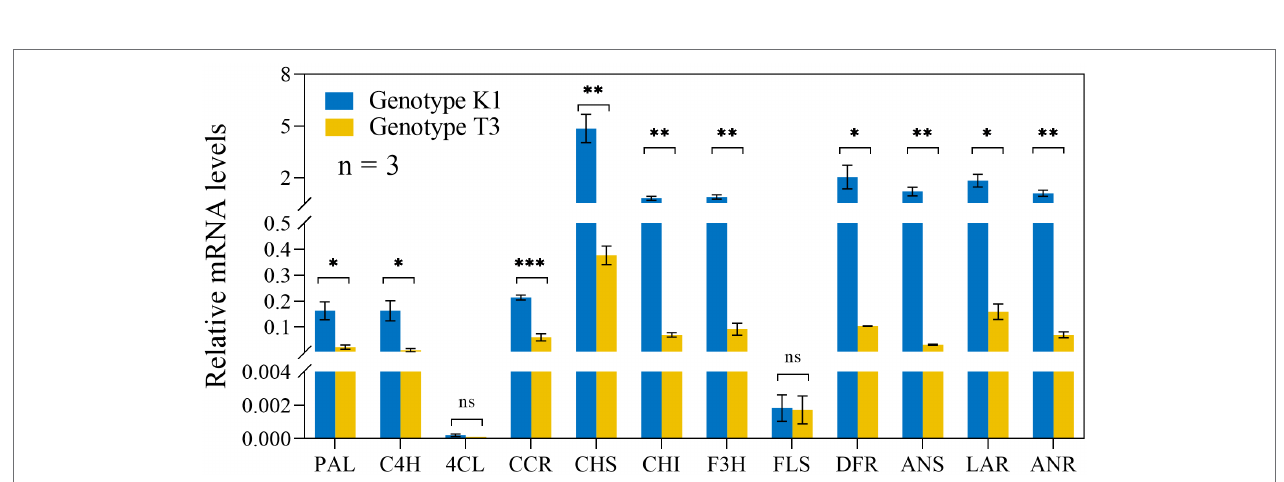
FIGURE 9 | Relative expression levels of genes involved in the phenylpropanoid pathway in leaves of Kreuzkogel 1 (K1) and Tenno 3 (T3) without B. cinerea inoculation were measured via qRT-PCR. All values were normalized to the expression level of the H4 and UBC9 housekeeping genes. Significant differences between two genotypes, based on the Wilcox test, are represented by ns p > 0.05, * p < 0.05, ** p < 0.01 and *** p < 0.001. PAL, PHENYLALANINE AMMONIA LYASE; C4H, CINNAMIC ACID 4-HYDROXYLASE; 4CL, 4-COUMAROYL-COA LIGASE; CCR: CINNAMOYL-COA REDUCTASE; CHS, CHALCONE SYNTHASE; CHI, CHALCONE ISOMERASE; F3H, FLAVANONE 3-HYDROXYLASE; FLS, FLAVONOL SYNTHASE; DFR, DIHYDROFLAVONOL REDUCTASE; ANS, ANTHOCYANIDIN SYNTHASE; LAR, LEUCOANTHOCYANIDIN REDUCTASE; ANR, ANTHOCYANIDIN REDUCTASE